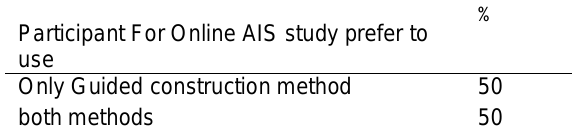
Table 5: Participants’ answers to their preferences